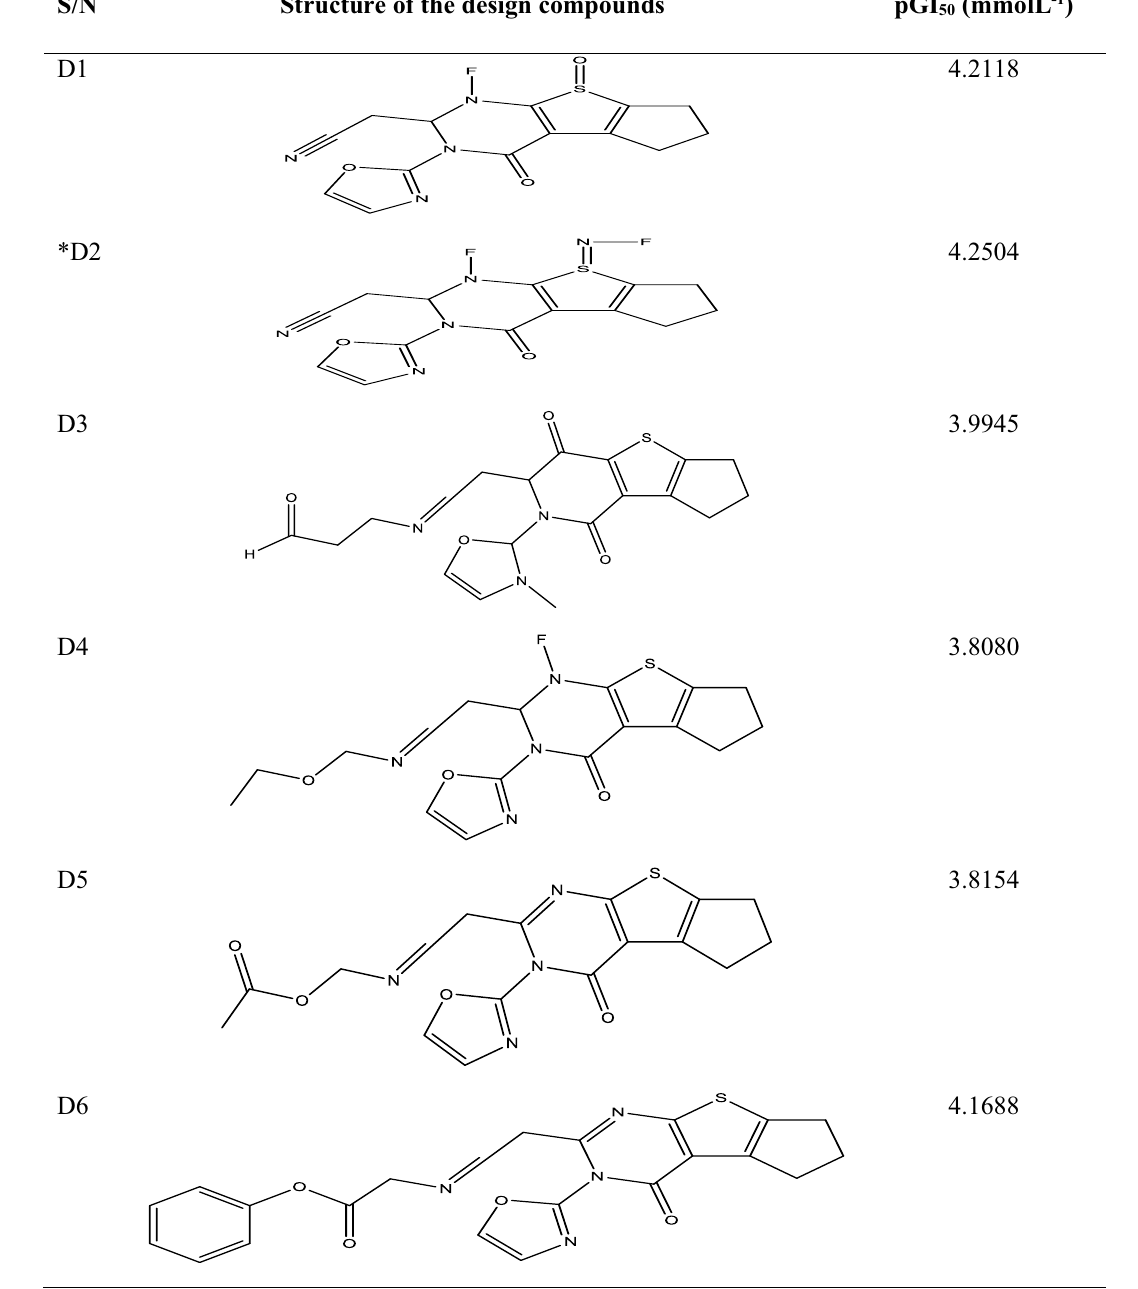
) of the design compounds 50